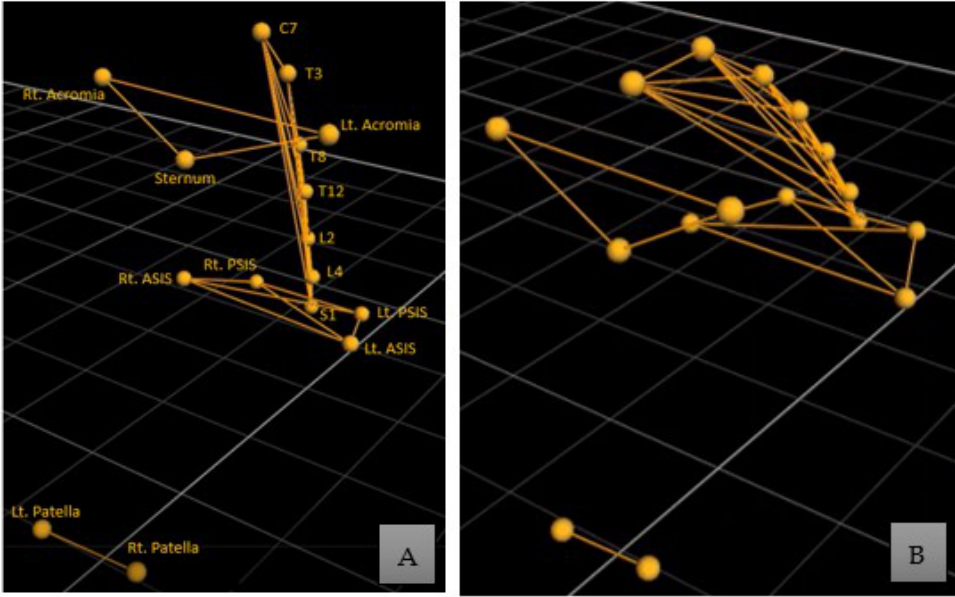
Figure 2. (A) Vicon markers positioned over the anatomical bony landmarks of a participant in a normal straight sitting position; (B) a flexion movement performed during the assessment. normal straight sitting position; ( B ) a flexion movement performed during the